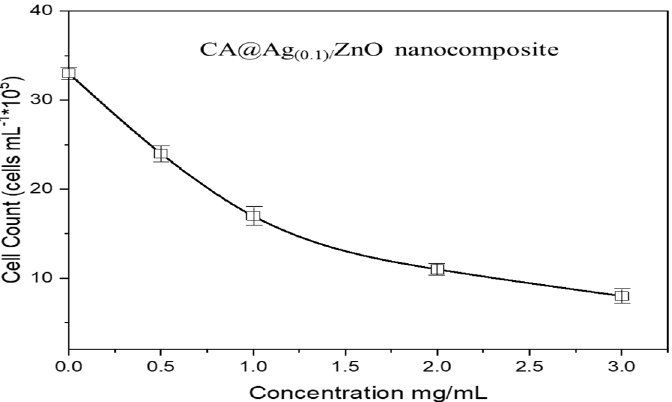
Figure 9. MCF7 cell counts at variable concentrations of CA@Ag (0.1)/ ZnO hybrid material (0.50, 1, 2, and 3 mg/Ml).